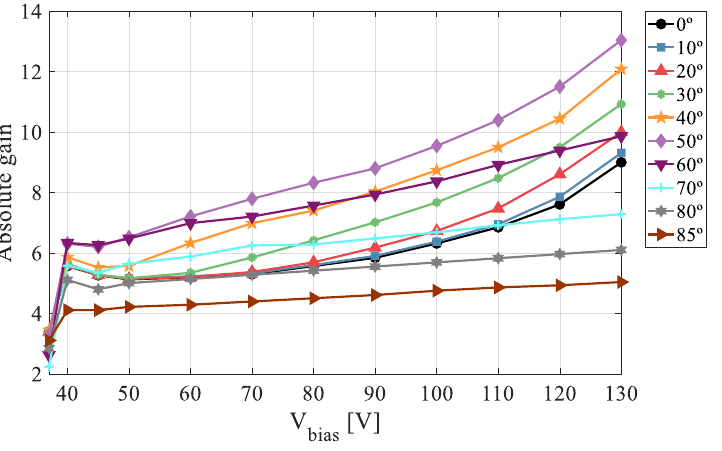
Figure 17. Absolute gain curves for angles from 0° to 85°.